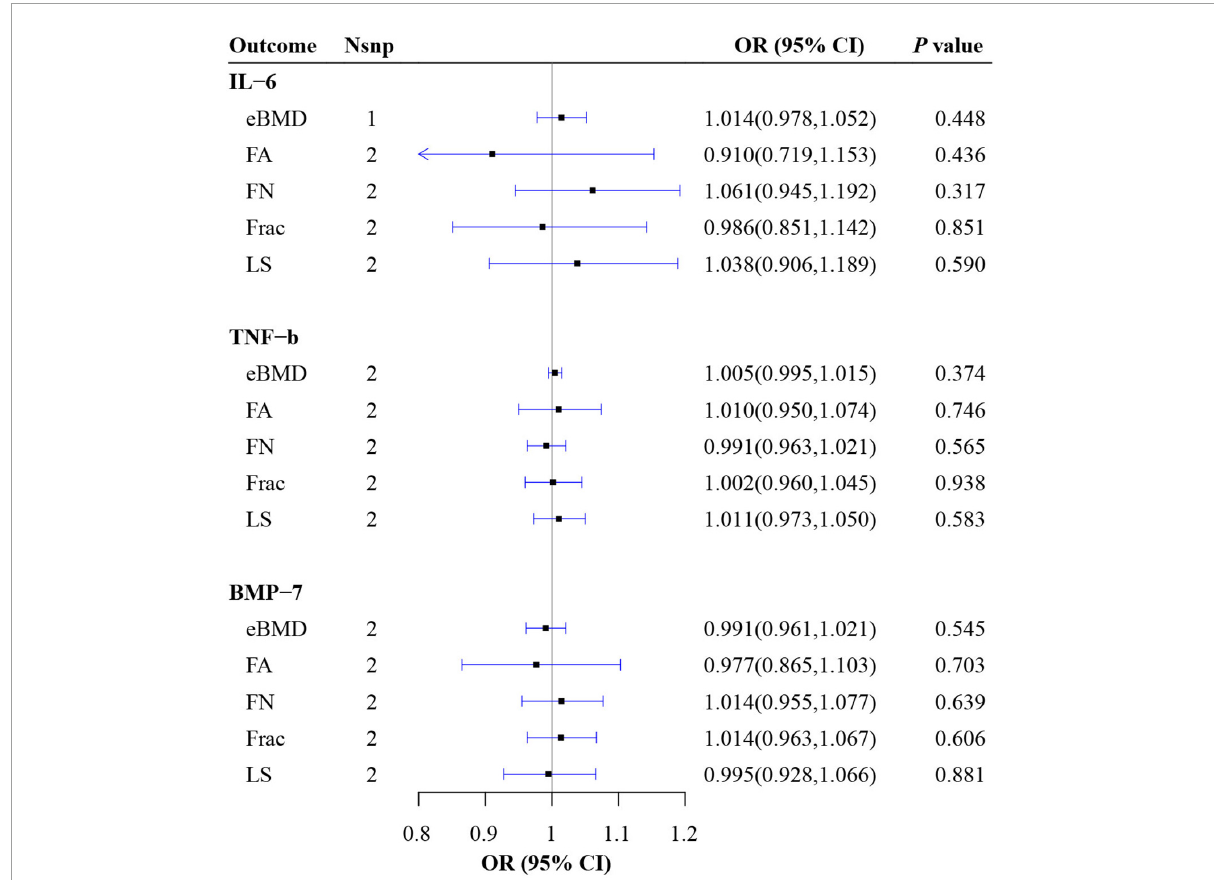
FIGURE3 Mendelian randomization (MR) estimate results of possible confounding factors on BMD. BMD, bone mineral density; eBMD, estimated BMD; FA, forearm; FN, femoral neck; LS, lumbar; IL, interleukin; TNF, tumor necrosis factor; BMP, bone morphogenetic